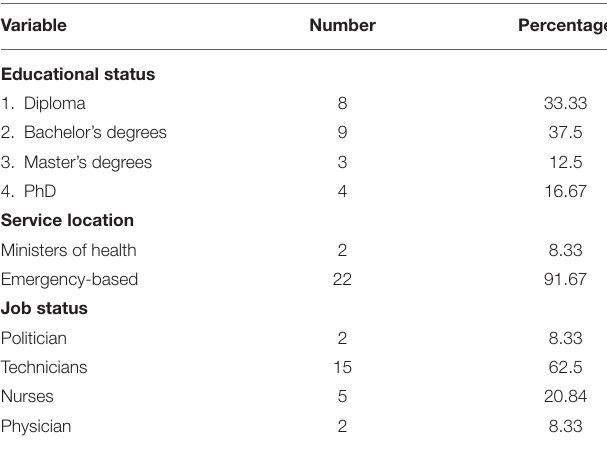
TABLE 1 | Distribution of interviews demographic